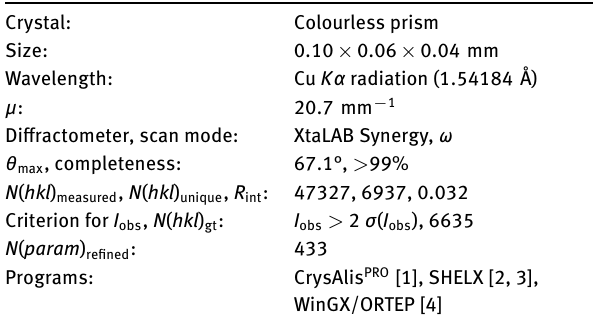
Table 1: Data collection and handling.